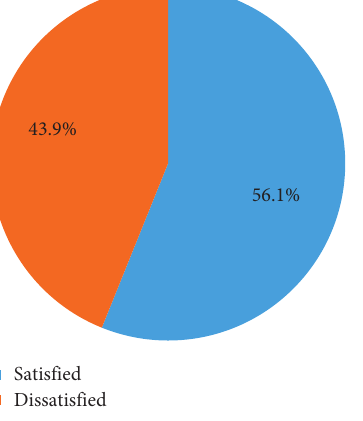
Figure 2: Patient satisfaction for outpatient health service users in North Gondar, Ethiopia, 2016 ( n � 408). Table 3: Bivariable and multivariable analysis of factors affecting patient satisfaction in North Gondar, Northwest Ethiopia, 2016 ( n � 408).